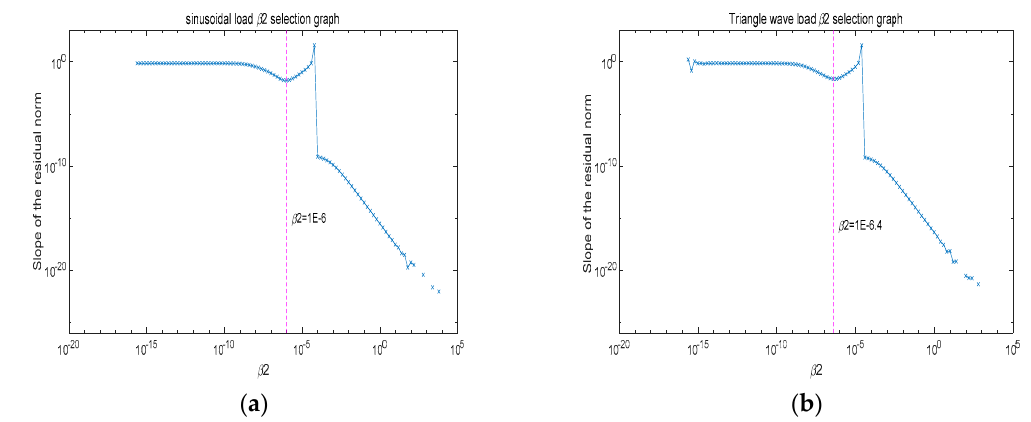
Figure 31. β 2 ignition value selection: ( a ) sinusoidal load; ( b ) triangle wave load.